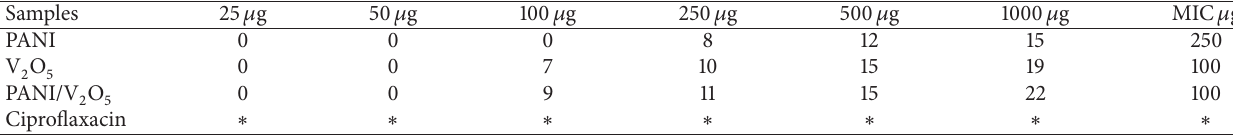
Figure 2: (a) Powder X-ray diffraction pattern of PANI. (b) Powder X-ray diffraction pattern of V 2 O 5 nanoparticle. (c) Powder X-ray diffraction pattern of 50 weight% of V 2 O 5 in PANI (V 2 O 5 /PANI nanocomposite). Table 1: Antibacterial activity results, zone of inhibition in mm (S. aureus) .